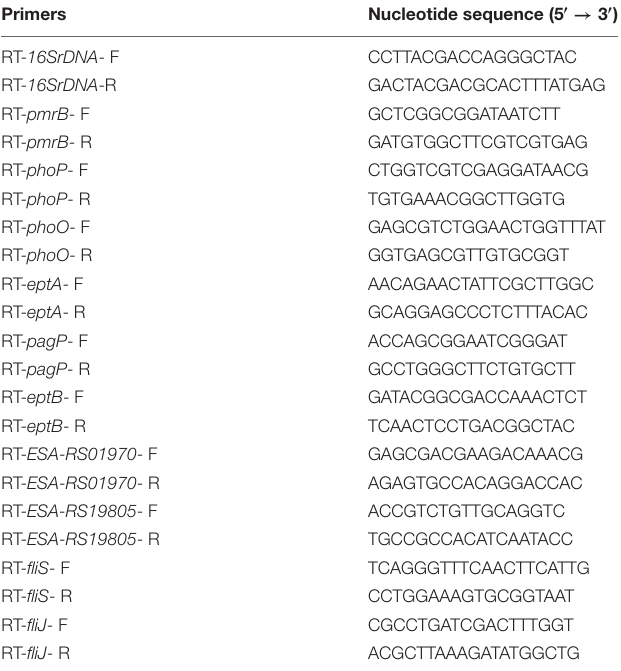
TABLE 4 | Primers used in RT-PCR. Primers Nucleotide sequence (5 (cid:48) → 3 (cid:48) )